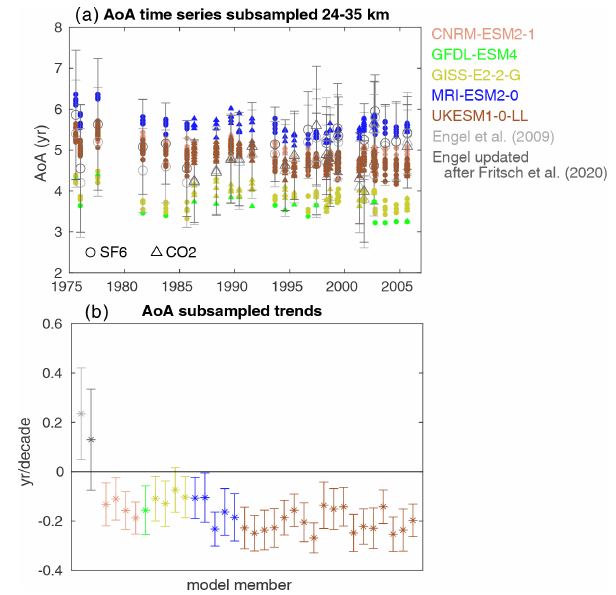
Figure 6. (a) Time series of AoA (in years) from individual model simulations sampled at the locations and times of the measurements from Engel et al. (2009), with different symbols representing the SF 6 and CO 2 measurements. Specifically, the zonal mean AoA has been averaged over the 24–35km range and evaluated at the lati- tude and month corresponding to each measurement. Observational estimates from Engel et al. (2009) and updated after Fritsch et al. (2020) are included for comparison. (b) Trends in the time series in (a) for each model member and the observational estimates, with error bars corresponding to the 95% confidence level. The trends are computed for the combined time series considering both tracers. The individual measurement uncertainties are taken into account to calculate the trend error